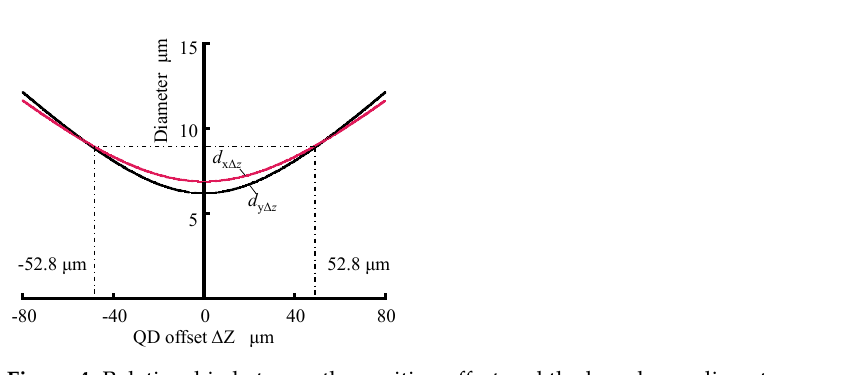
Figure 4. Relationship between the position offset and the laser beam diameter.